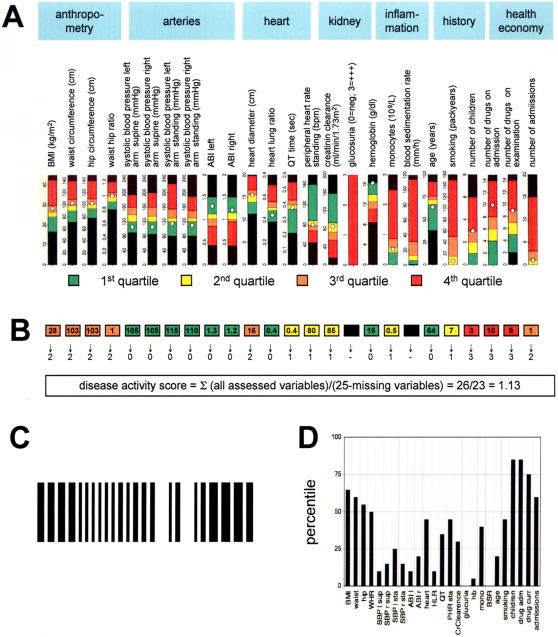
Empiric clinical profiles of arteriosclerosis and disease activity score.A. Reference range of data obtained from each of the 25 significantly different variables in symptomatic patients. An individual patient's data (represented as white dots) are superposed onto the color-coded quartile distribution. B. The same individual patient's color-coded empiric clinical disease profile of arteriosclerosis. The color-coded profile can be transformed into numbers: green = 0, yellow = 1, orange = 2 and red = 3. The arithmetic mean of these numbers is equivalent to the disease activity score. C. The color- or number-coded profiles can be transformed into a barcode. D. The individual patient's quantitative percentile profile.